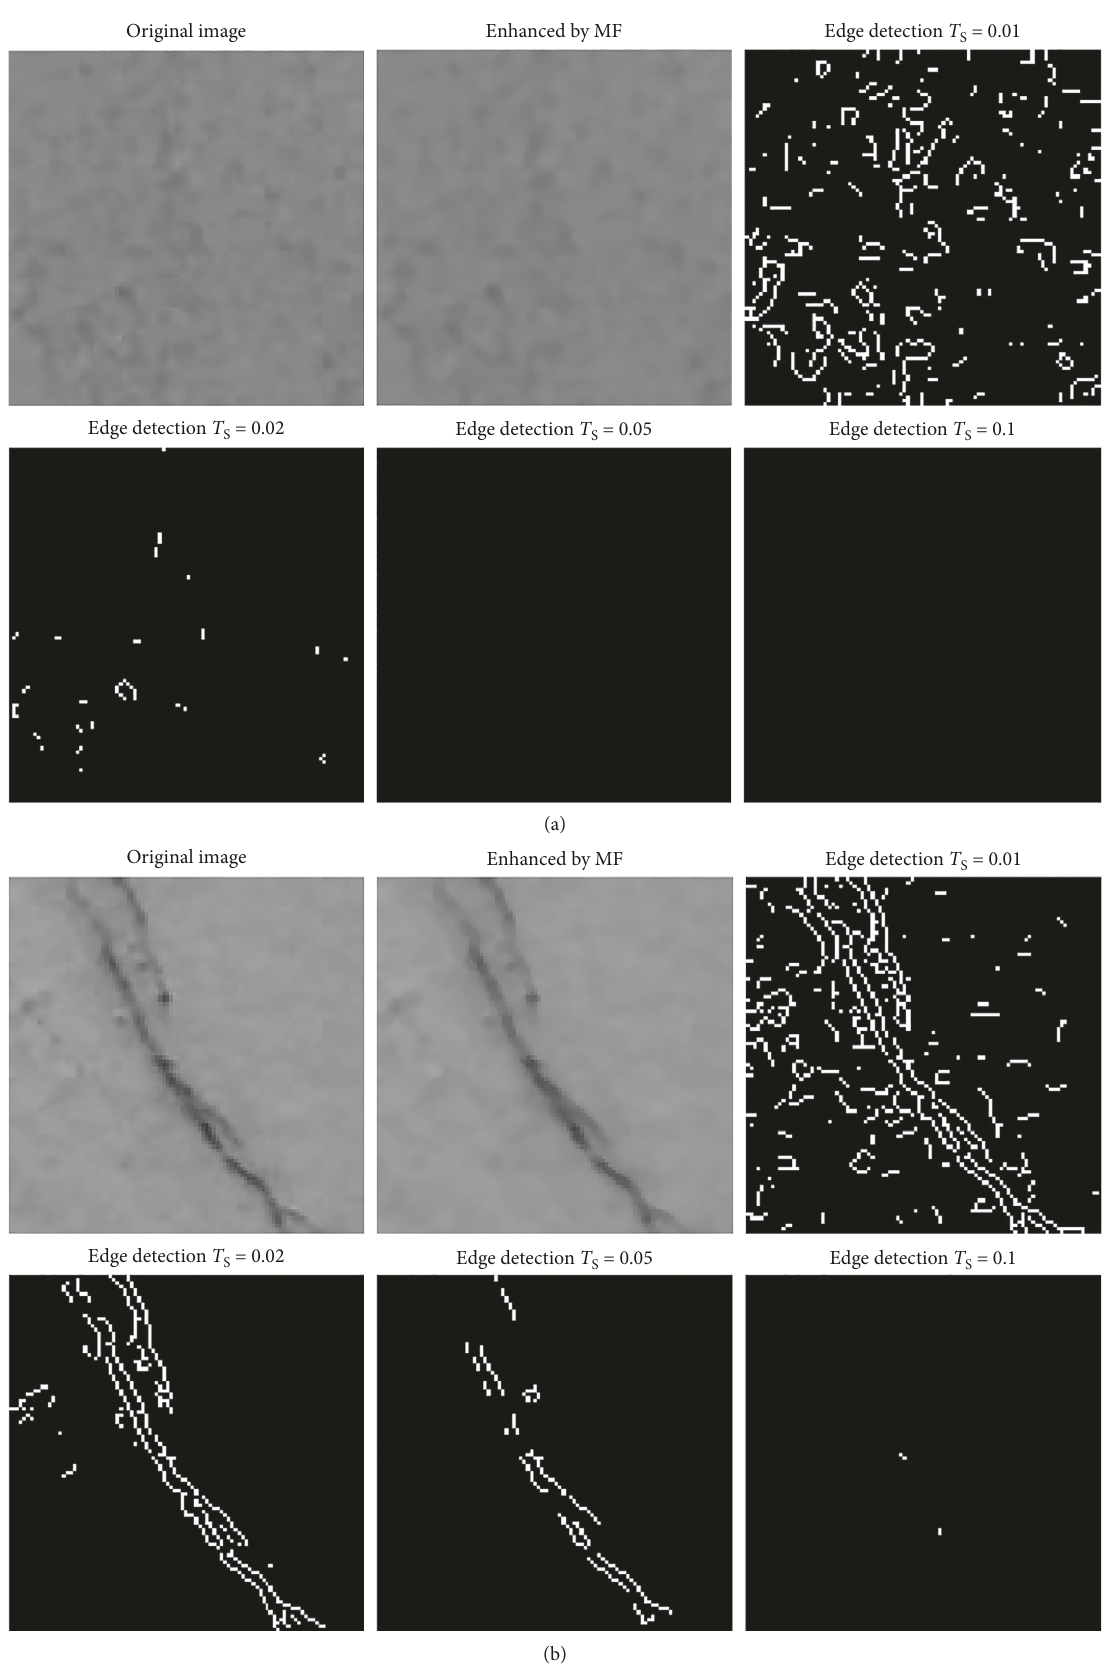
Figure 3: Edge detection outcome employing the Sobel method: (a) an image without cracks and (b) an image with